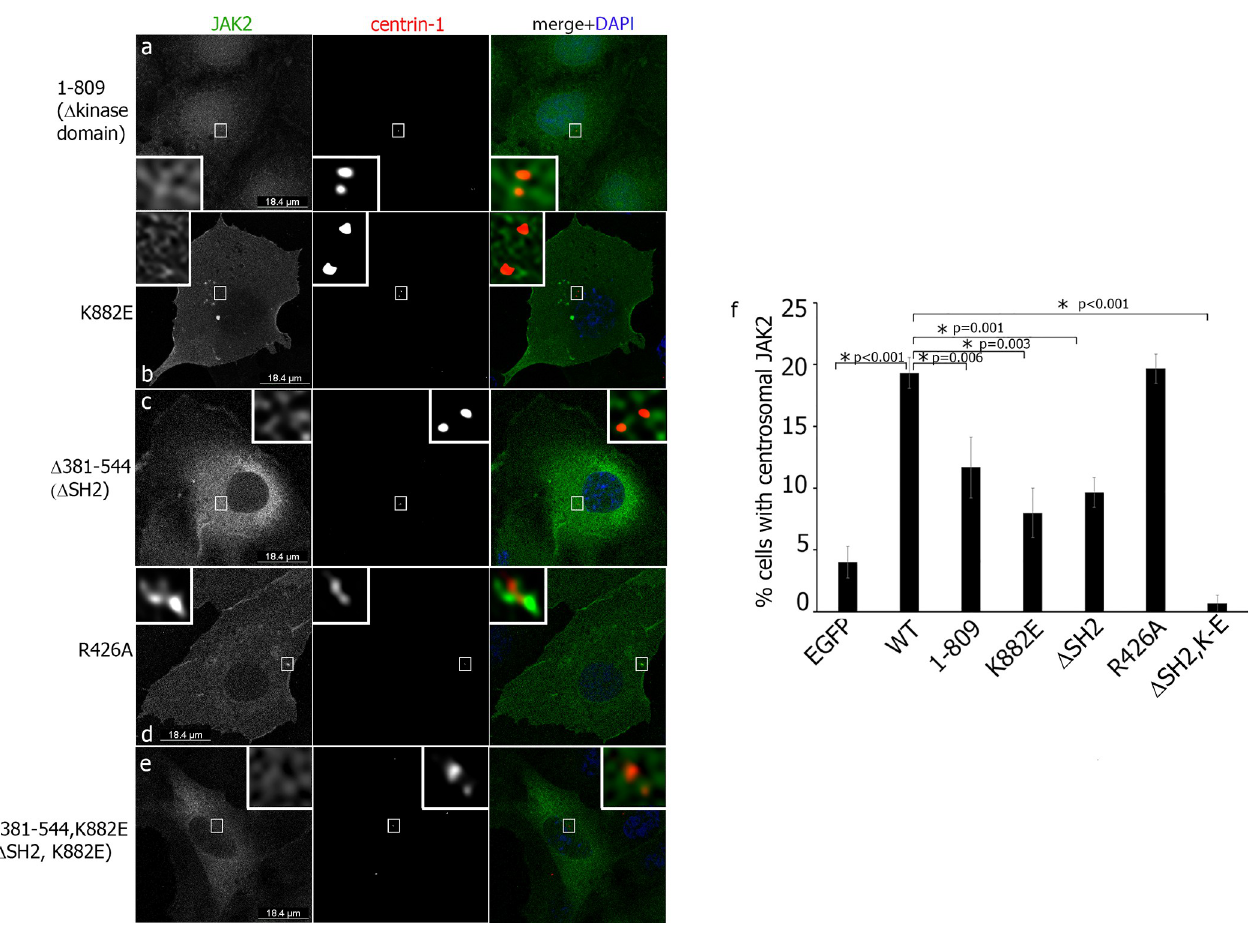
Fig 4. Both SH2 domain-containing amino acids 381–544 and kinase activity are required for centrosomal localization of JAK2. ( a-e ) COS-7 cells transiently overexpressing indicated forms of EGFP-JAK2 mutants (green in the merged image) were immunolabeled with anti-centrin-1 AB (red in the merged image). DAPI stains cell nuclei (blue in the merge image) The insets show enlarged centrosomes. ( f ) The number of EGFP-positive cells with centrosomal JAK2 were scored and plotted. 50 cells were assessed in each experiment for each type of transfection. N = 9 for EGFP and WT cells, n = 6 for (1– 809), ( Δ 381–544) and R425 mutants. N = 3 for (1–809), K882E and ( Δ 381–544; K822E) mutants. Bars represent mean ± SE. � , P < 0.05 compared with WT cells.